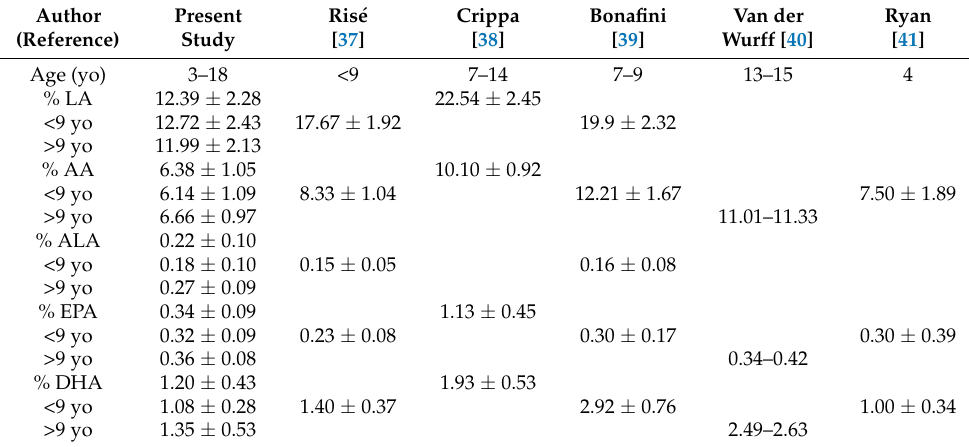
Table 4. Relative quantities of relevant fatty acids observed in our study in comparison with data present in the literature. Fatty acid data are expressed as mean ± standard deviation of the relative percentage values, or, in the case of [40], the range of percentage values. For studies examining differences in the FA profile between control and pathological subjects, the values of the control group were considered.